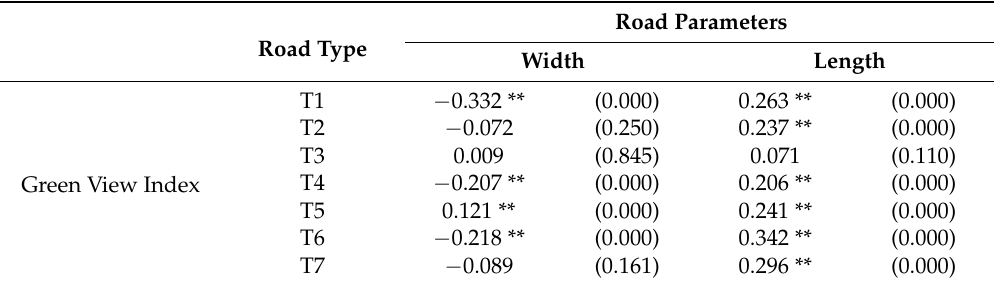
Table 2. The correlation between road parameters and green view index (GVI) values of different road